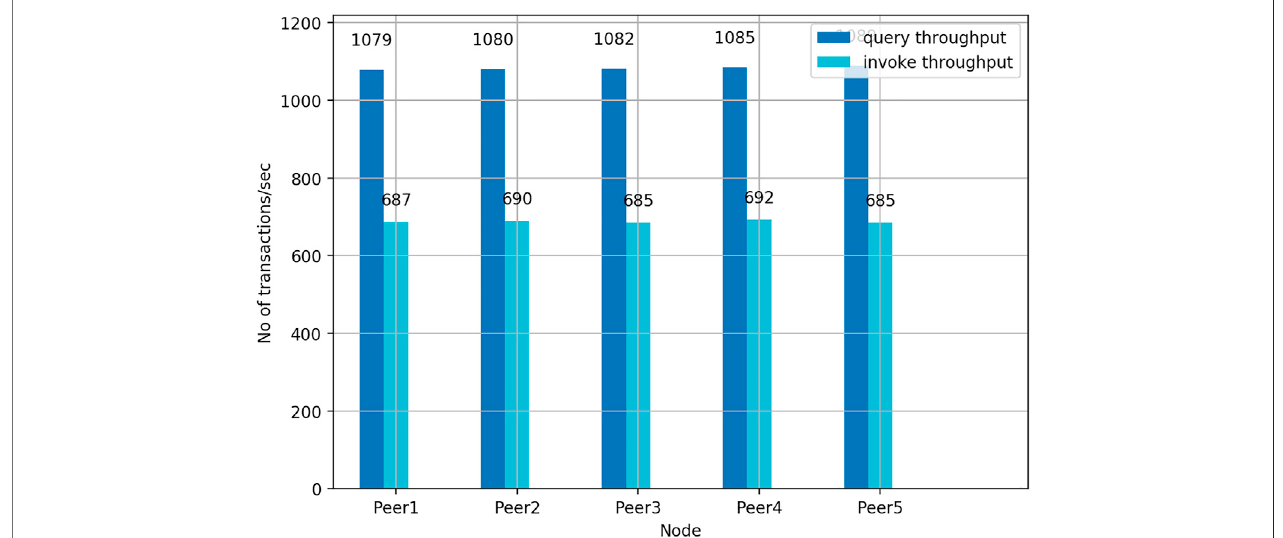
FIGURE 4 | Invoke and query transaction throughput of single blockchain peer in the Vind platform.